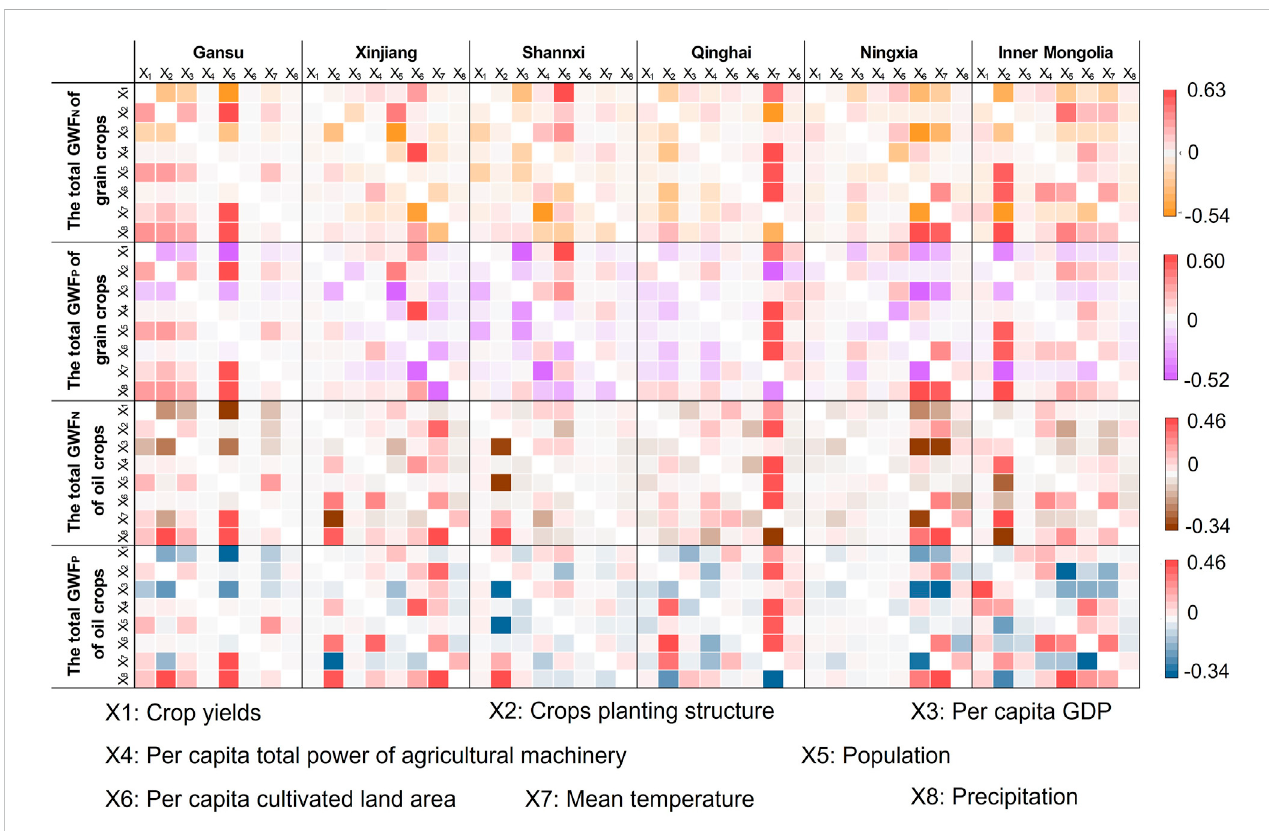
FIGURE 7 Indirect effects of various factors on the total GWF of grain crops and oil crops in the six western provinces.